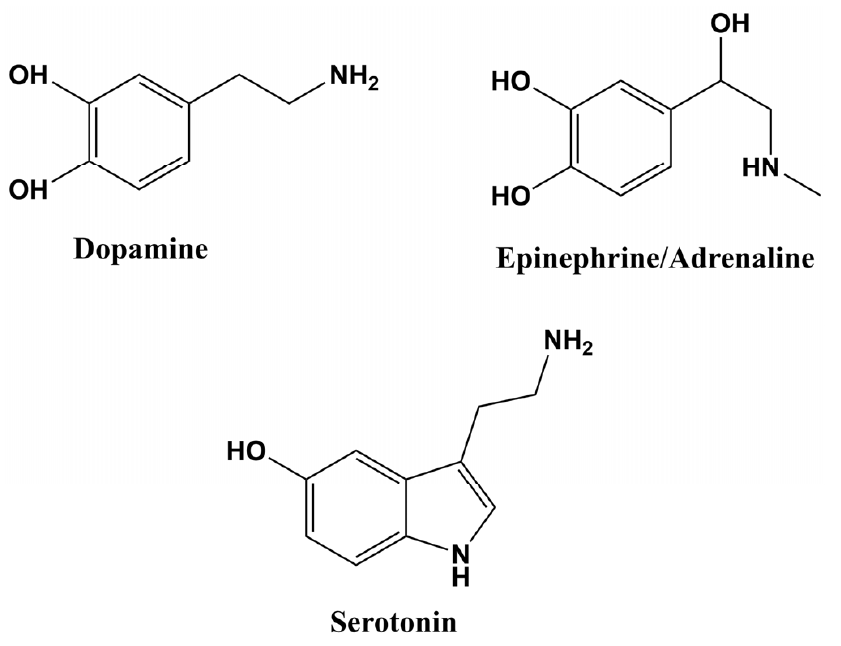
Figure 1. The chemical structures of DA, EPI and SER.